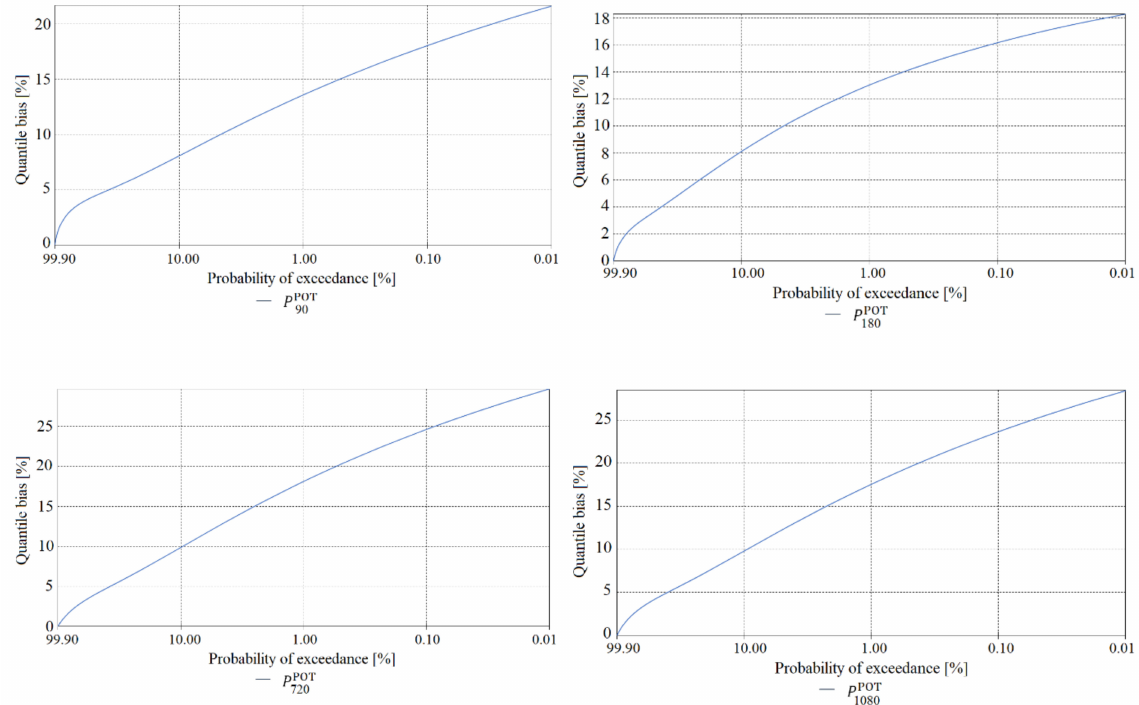
Figure 15. Comparison of estimated values of quantile error resulting from the randomness of the sample of maximum precipitations computed using the PMAXTP model for the random variable P POT τ with durations τ = {90, 180, 720, 1080} min, for the Bialystok meteorological